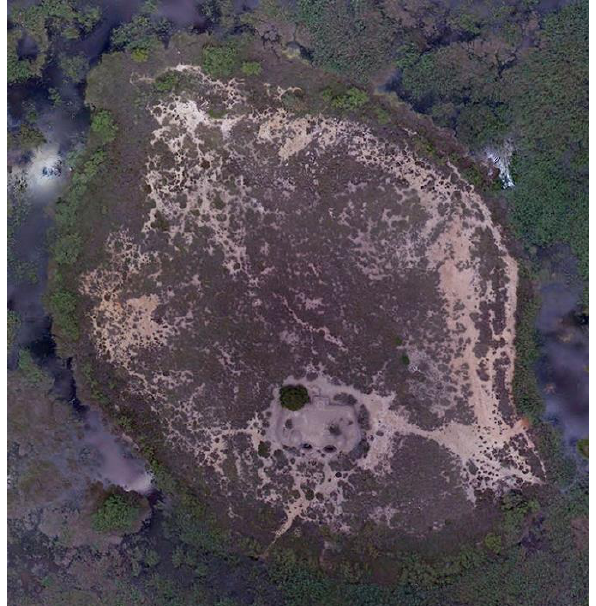
Figure 5. Aerial view (ortho-photograph) of the surroundings of